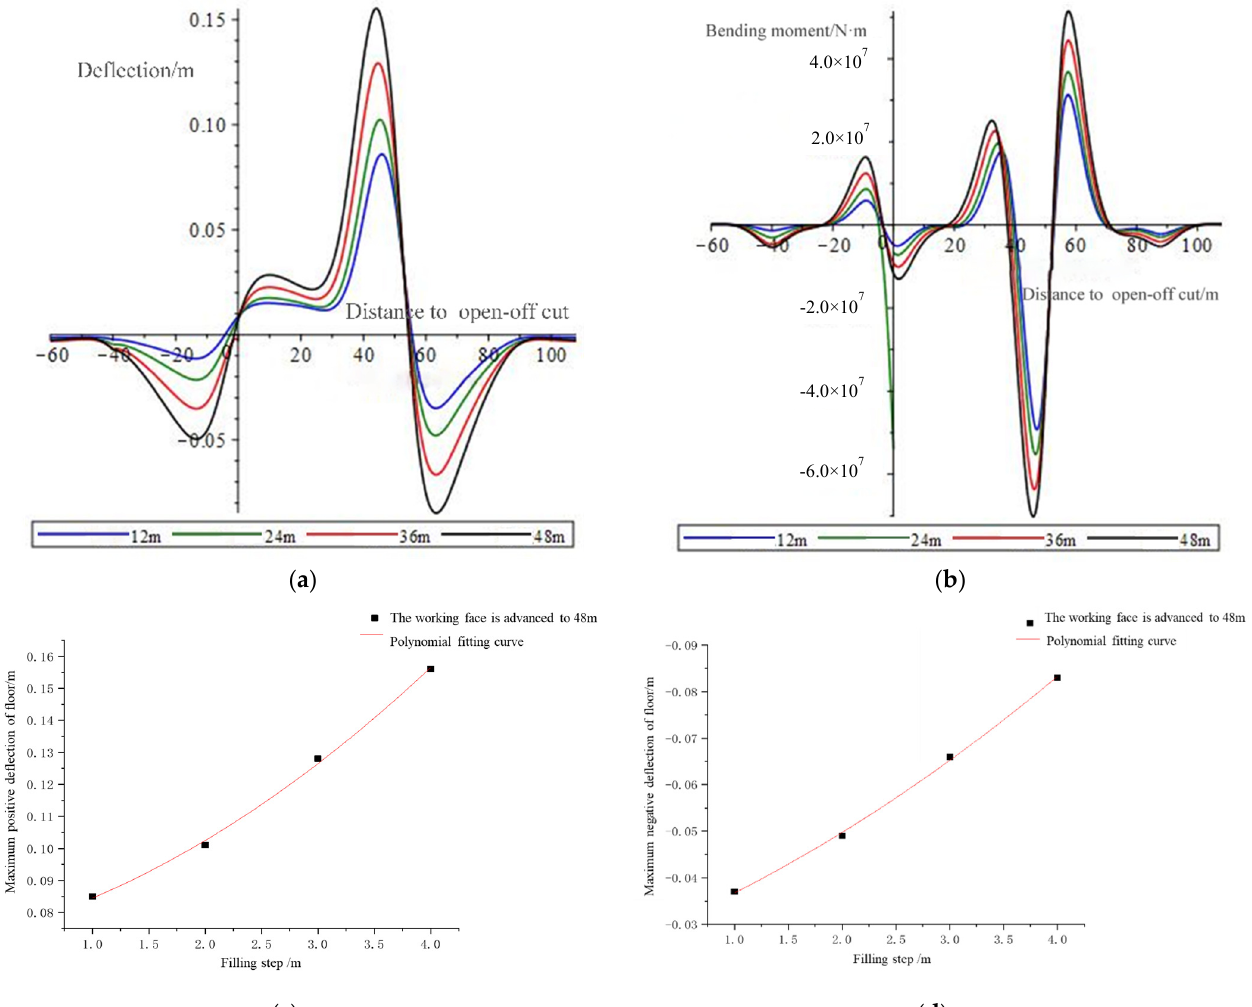
Figure 3. ( a ) Floor deflection under different filling steps; ( b ) Floor bending moment under different filling steps; ( c ) The relationship between the filling step and the maximum positive deflection of the floor; ( d ) The relationship between the filling step and the maximum negative deflection of the